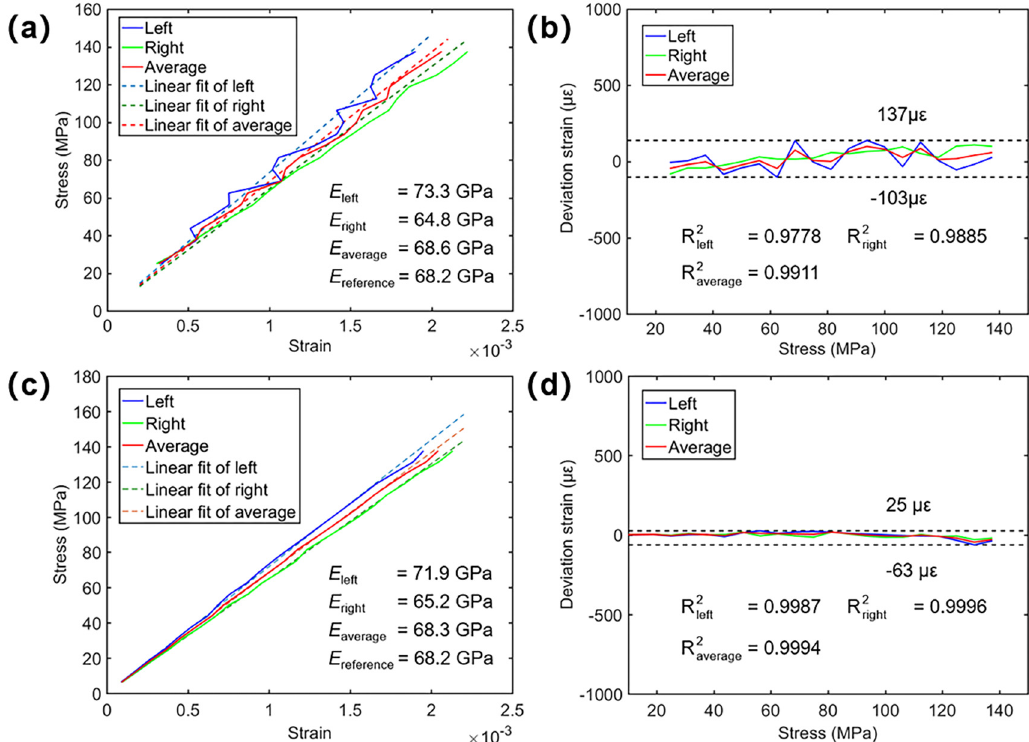
Figure 11. Tensile tests performed with the smartphone-based single-camera panoramic DIC system: ( a ) experimentally measured stress–strain curves and corresponding linear fitting ( b ) deviations between the measured and fitted strains. Tensile tests performed with the industrial-camera-based single-camera panoramic DIC system: ( c ) experimentally measured stress–strain curves and corresponding linear fitting ( d ) deviations between the measured and fitted strains. The R squared (R 2 ) is the coefficient of determination, which provides a measure of how well the observed outcomes are replicated by the model.